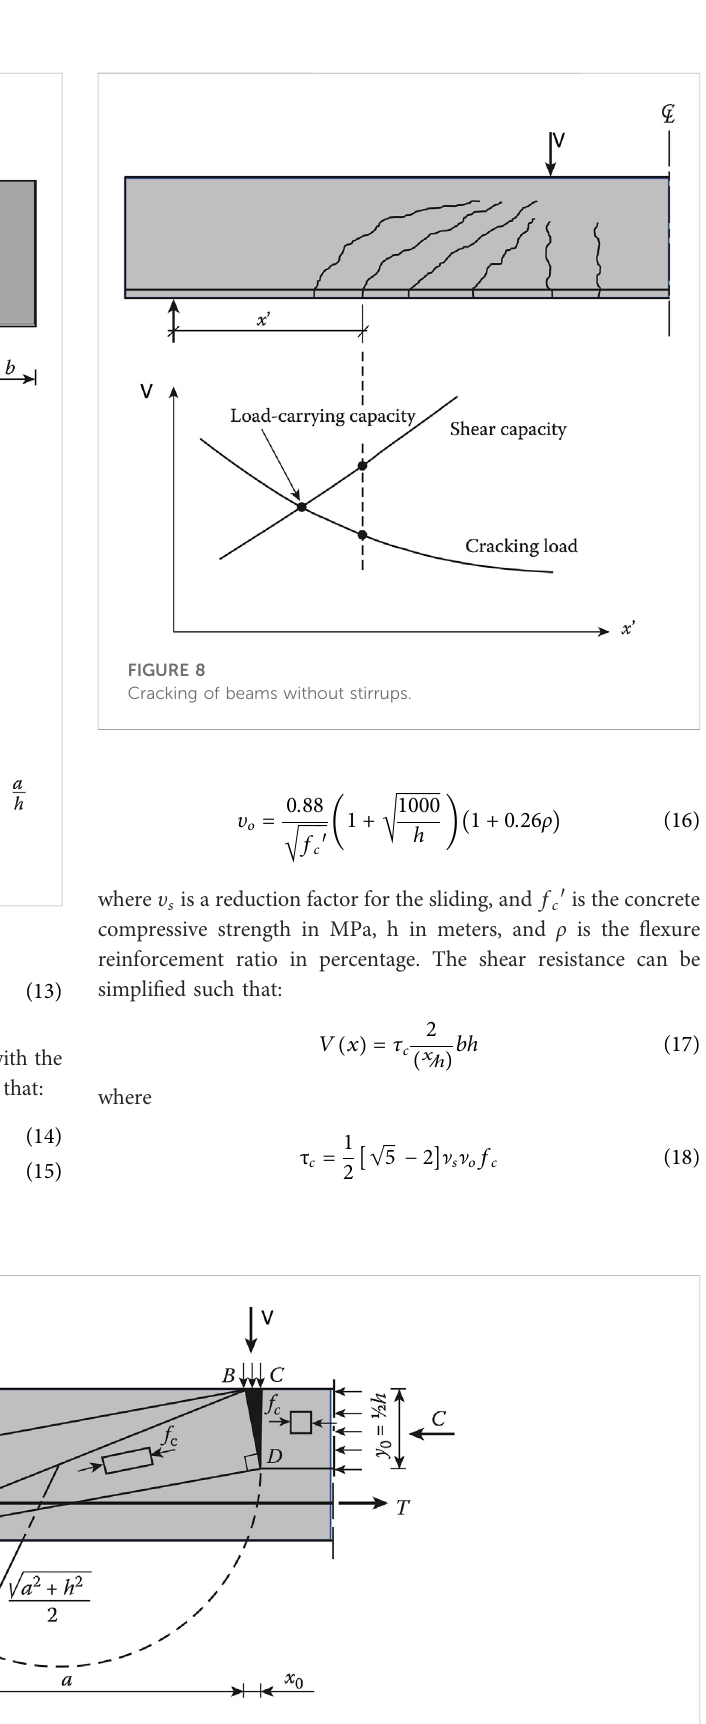
FIGURE 7 Lower bound solution for beam without stirrups.